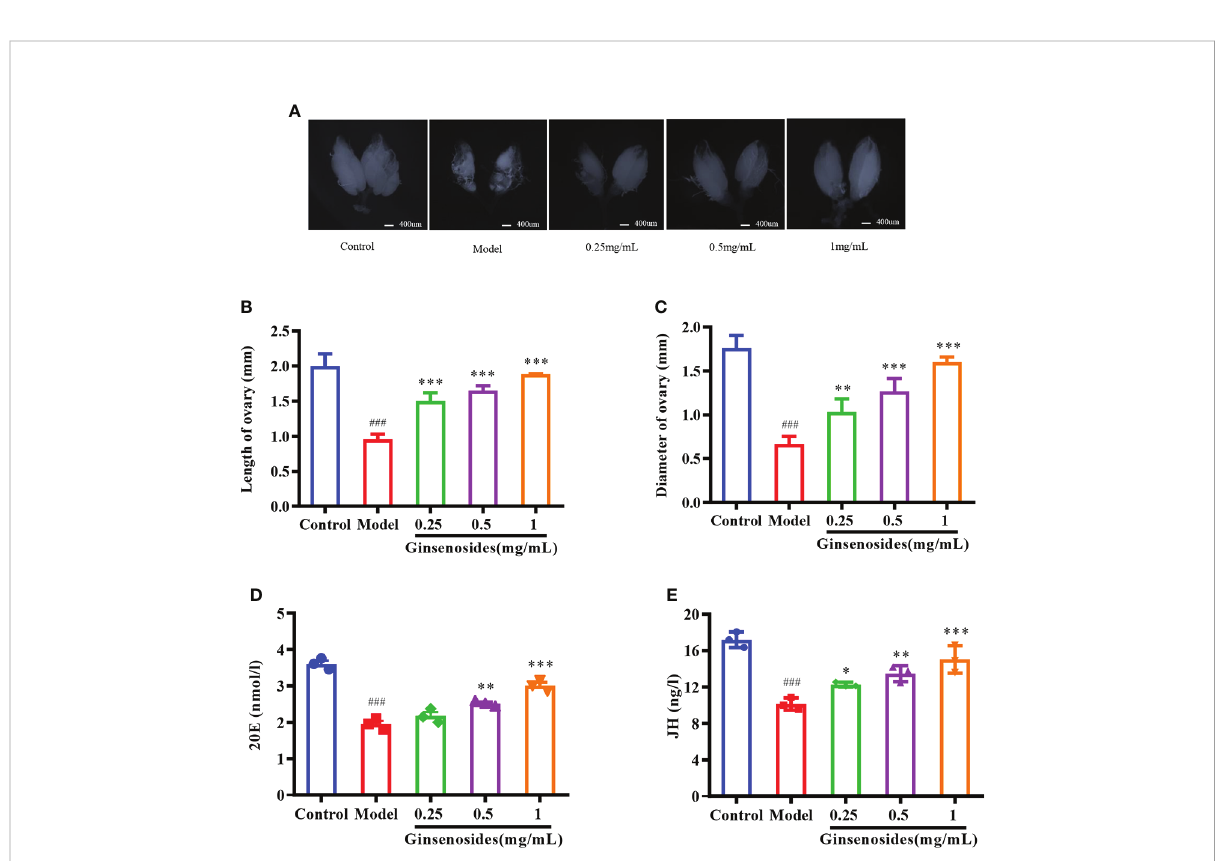
FIGURE 2 Effect of ginsenosides on ovarian function in Drosophila . (A) Ovary size; (B) Length of ovary; (C) Diameter of ovary; (D) 20E content; (E) JH content. * p <0.05, ** p <0.01, *** p <0.001 compared with model (35-day-old female Drosophila ); ### p <0.001 compared with control (7-day-old female Drosophila